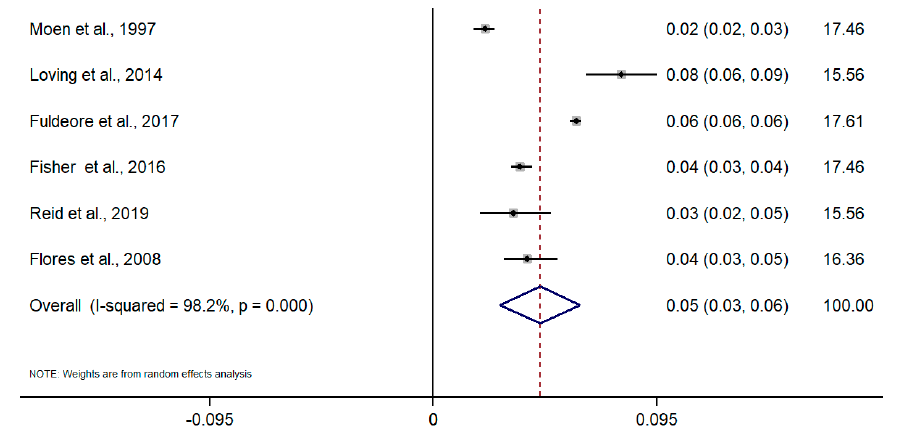
Figure 2. Meta-analysis of the prevalence of endometriosis based on self-Reported questionnaires. Note: black lines with squared dots—the prevalence with confidence intervals for each individual study; rhombus—pooled prevalence with confidence interval; red dotted line—line of no effect (studies crossing the line are not statistically different).